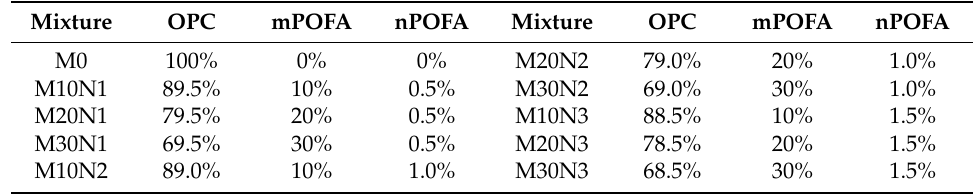
Table 1. Binder composition of different concretes.